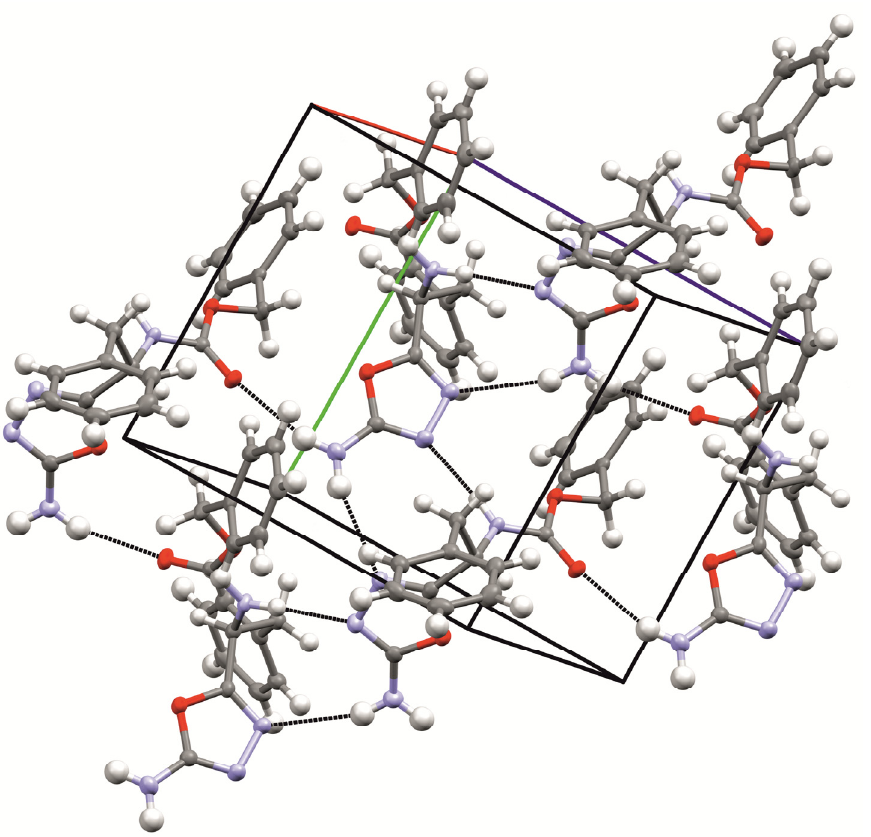
Figure 3. Crystal packing of 2 . Dashed lines are indicating hydrogen bond contacts. Lattice